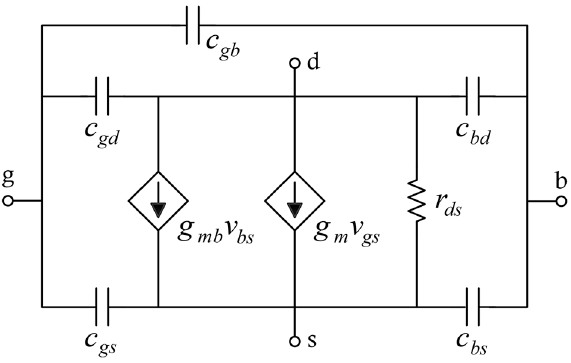
Figure 5. Small signal representation of MOS transistors. Table 2. Model parameter se tt ings.